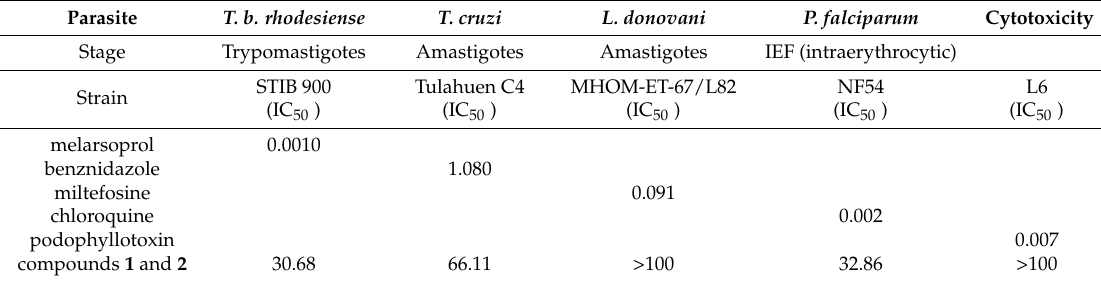
Table 4. In vitro antiprotozoal and cytotoxic activities of 1 and 2 . Values expressed in µ g ml -1 .